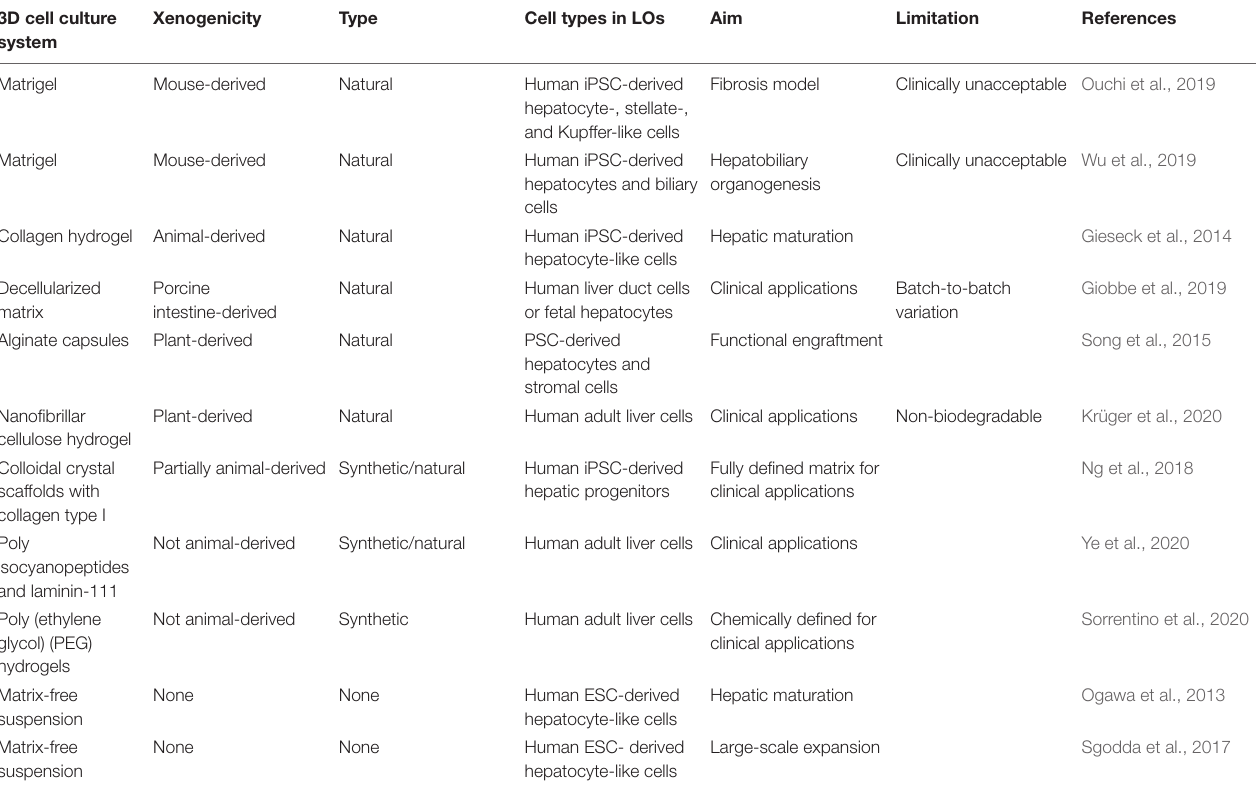
TABLE 1 | 3D cell culture systems for human